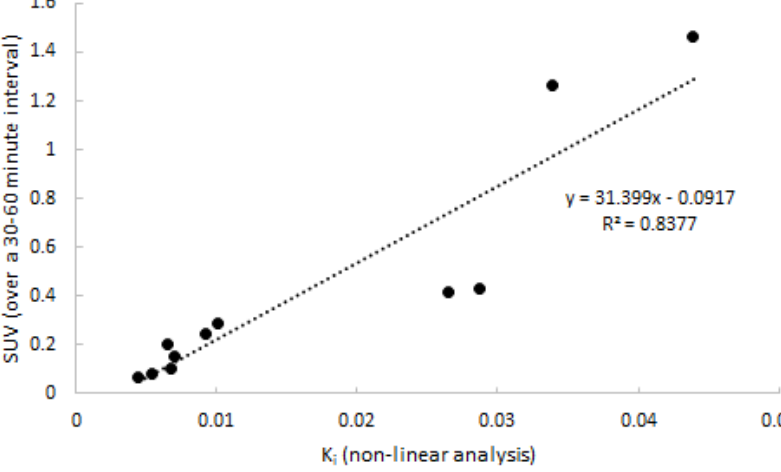
Figure 7. Correlation between SUV and 2T3k-derived K i . Data consist of both clinically affected and non-affected joints.